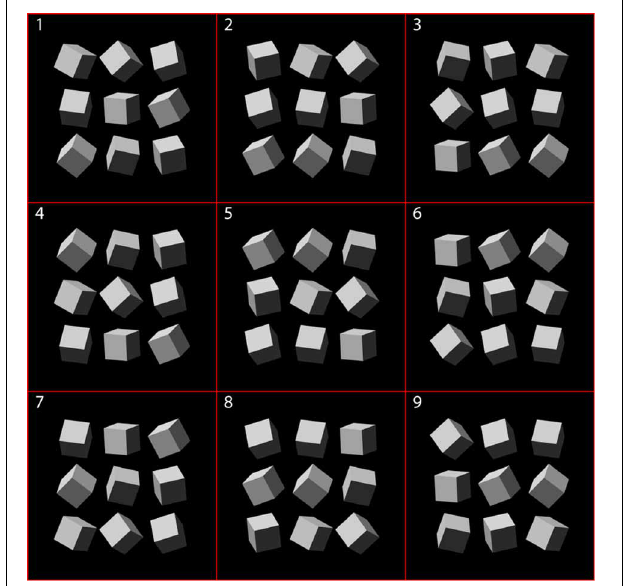
FIGURE 1 | Cube configurations arranged in the nine unique 3 × 3